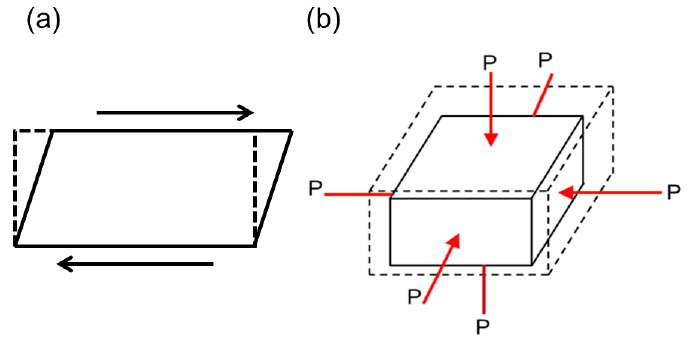
Figure 5. Schematic showing ( a ) shear deformation and ( b ) bulk/volumetric deformation. Black arrows show shear loading, red arrows show loading due to hydrostatic pressure, dashed lines show original ( a ) shape and ( b ) volume.